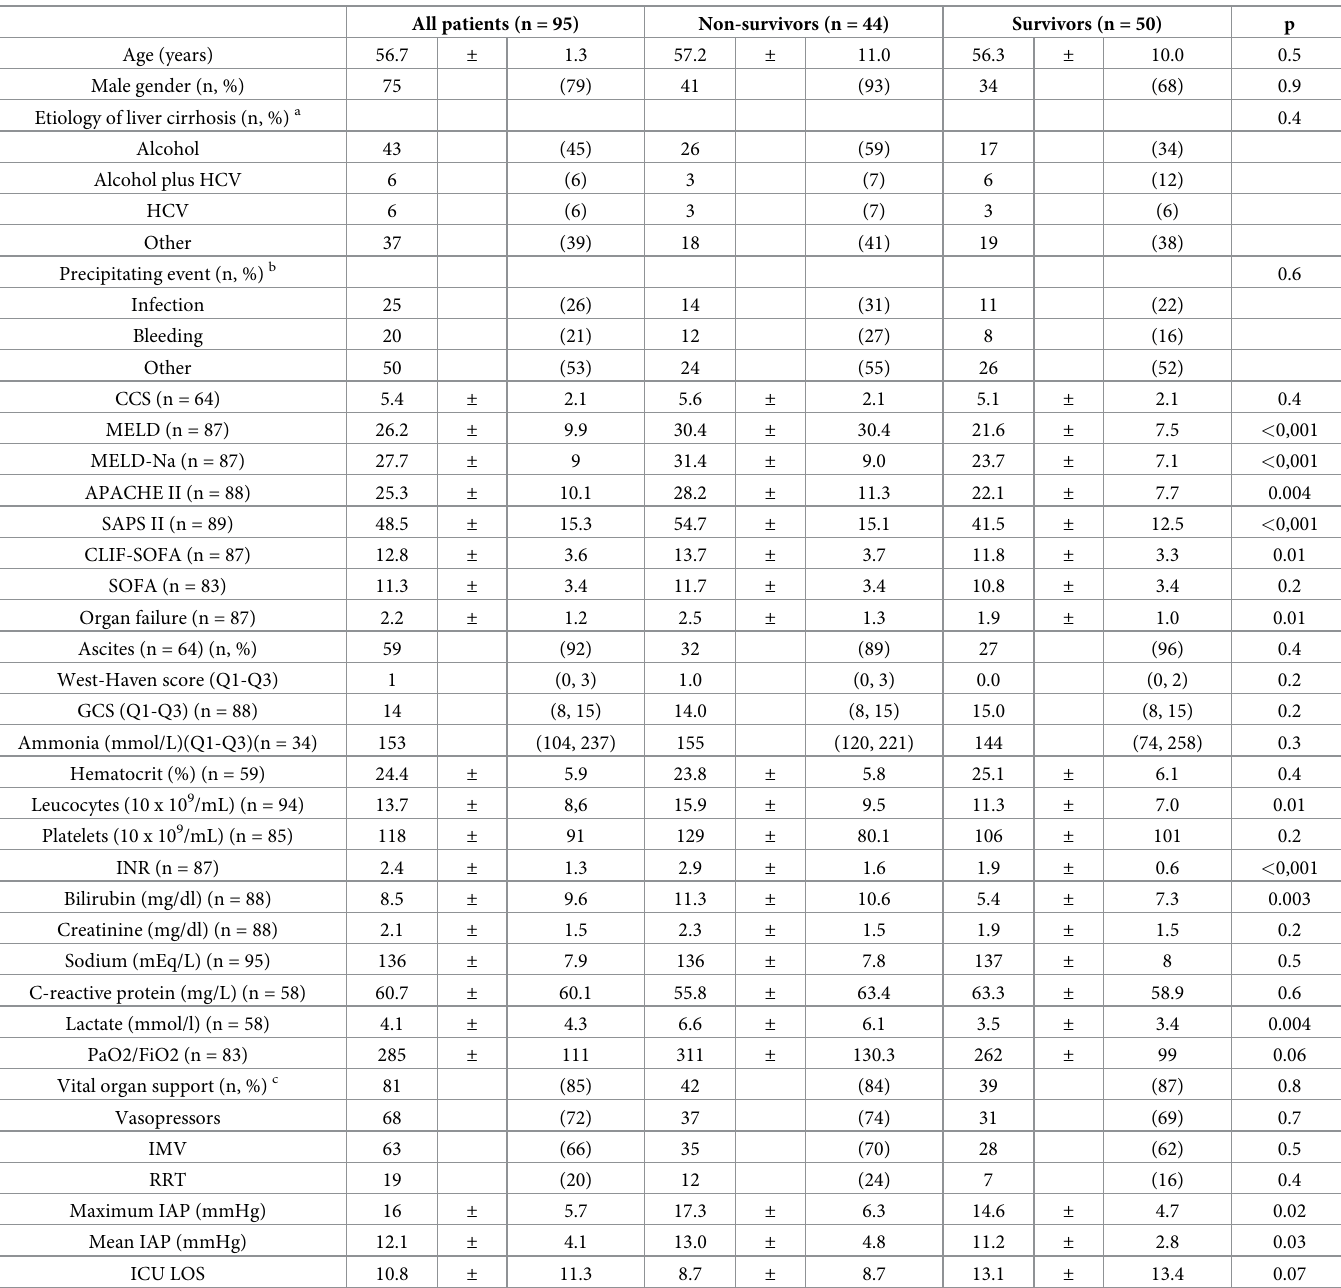
Table 1. Baseline characteristics of liver cirrhosis patients in intensive care and 28-day